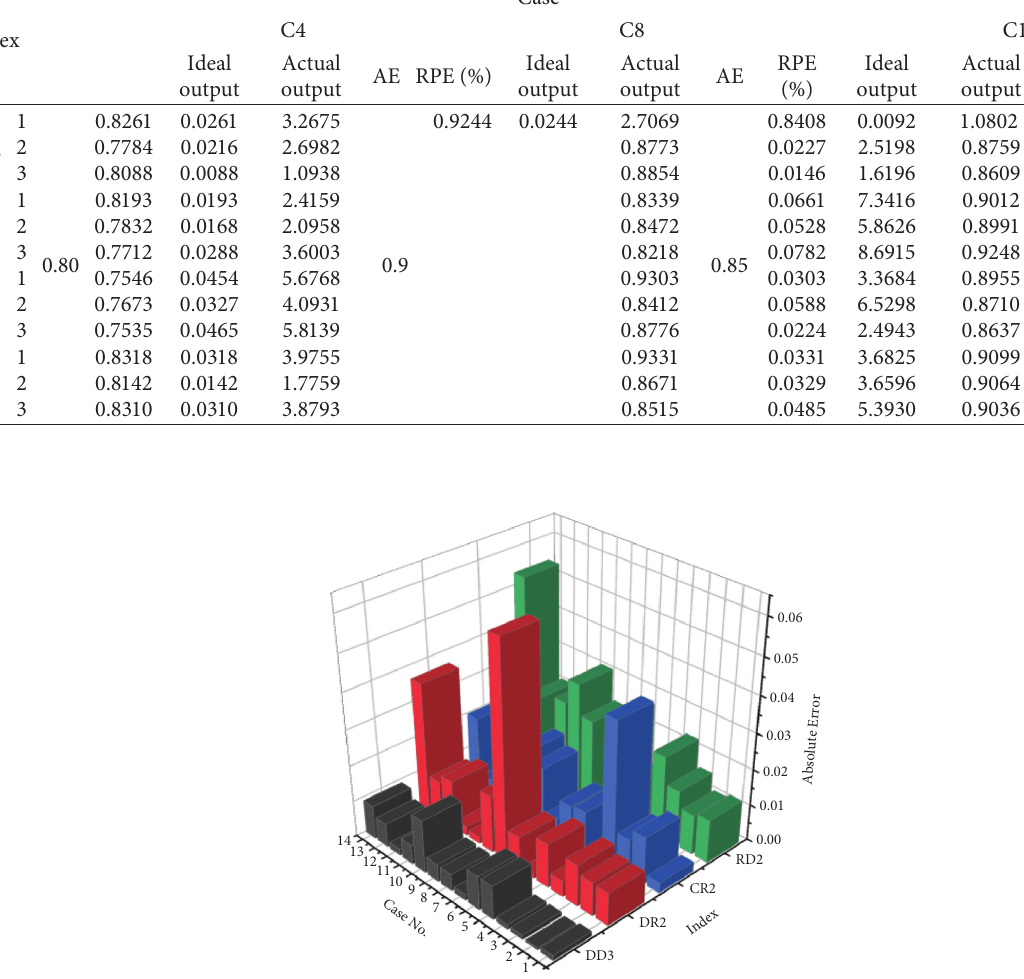
Figure 14: Comparison of absolute error of damage degree.